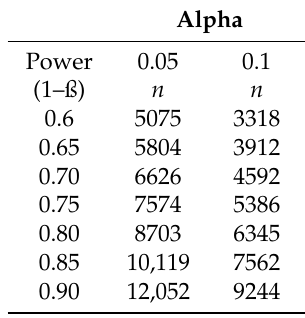
Table 6. Samples sizes required to detect the e ff ect of air pollution exposure on hypertension.